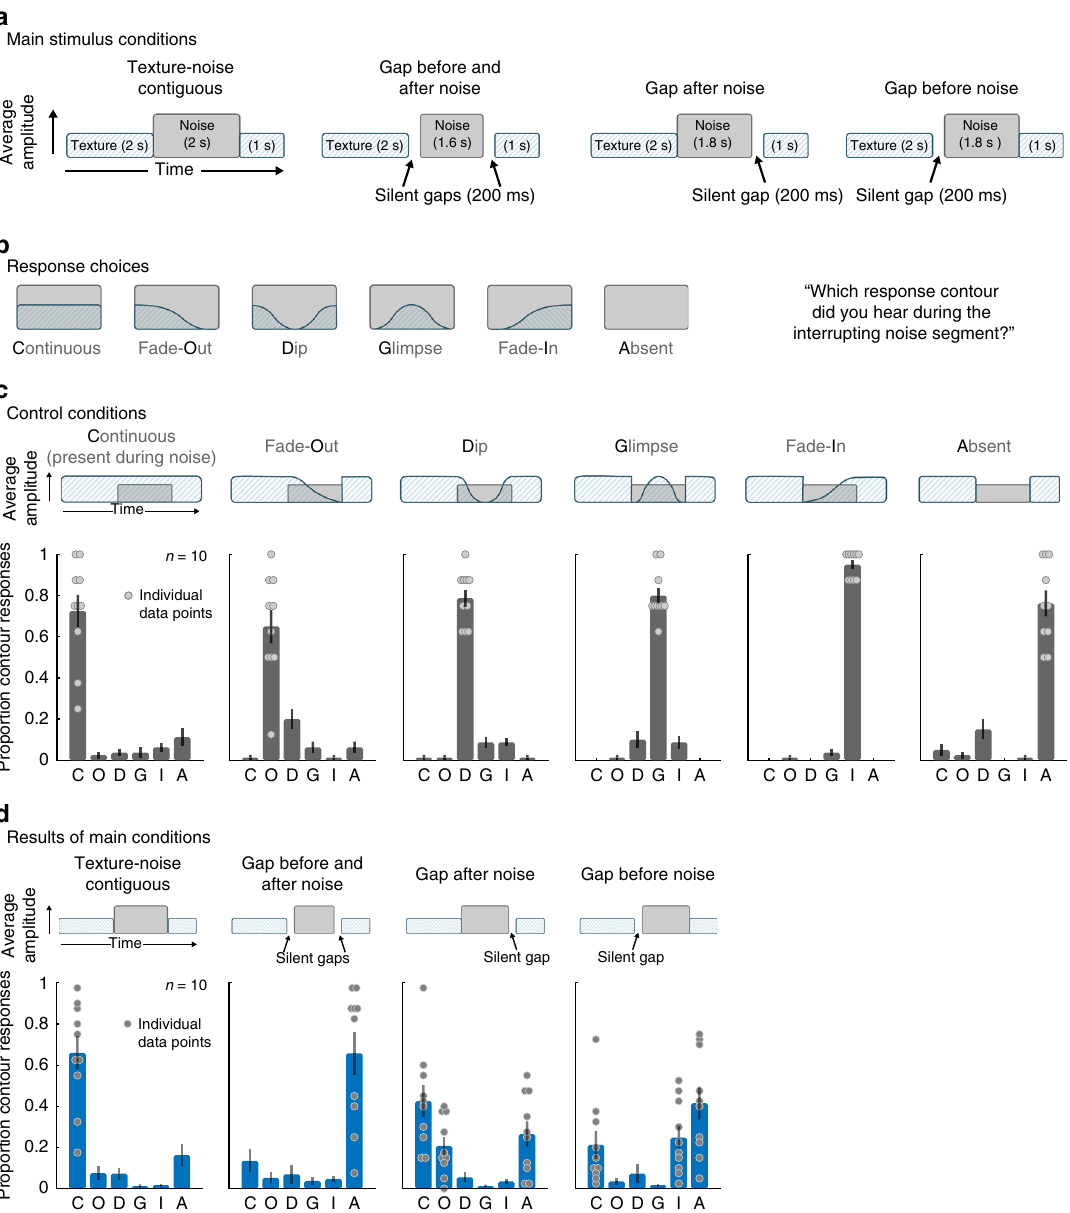
Fig. 6 Experiment 5 — effect of gaps on texture continuity. a Listeners heard a synthetic inducer texture interrupted with masking noise and reported their perceptual experience during the interrupting noise segment. The experiment included 4 conditions, differing in the contiguity of the texture and noise (via silent gaps inserted before and/or after the noise). See Supplementary Fig. 5 for analogous experiment with real-world texture recordings (which yielded similar results). b Listeners chose one of six response contours to describe their perceptual experience during the interrupting noise segment. The contour response code is indicated as the bolded letter for each response (e.g. “ C ” for “ Continuous ” ). c To con fi rm task comprehension/compliance, the experiment included control trials where the texture was physically present during the intermediate noise segment and amplitude modulated according to one of the response contours. The stimulus for each condition is schematized above each of the six subplots. Graphs plot the proportion of trials on which each response was chosen. Data for individual participants is plotted as dots for the response choices selected above chance levels for each condition. d Results of main experimental conditions. Each subplot corresponds to a condition (shown schematically above). Data for individual participants is plotted as dots for the response choices selected above chance levels for each condition. Error bars show